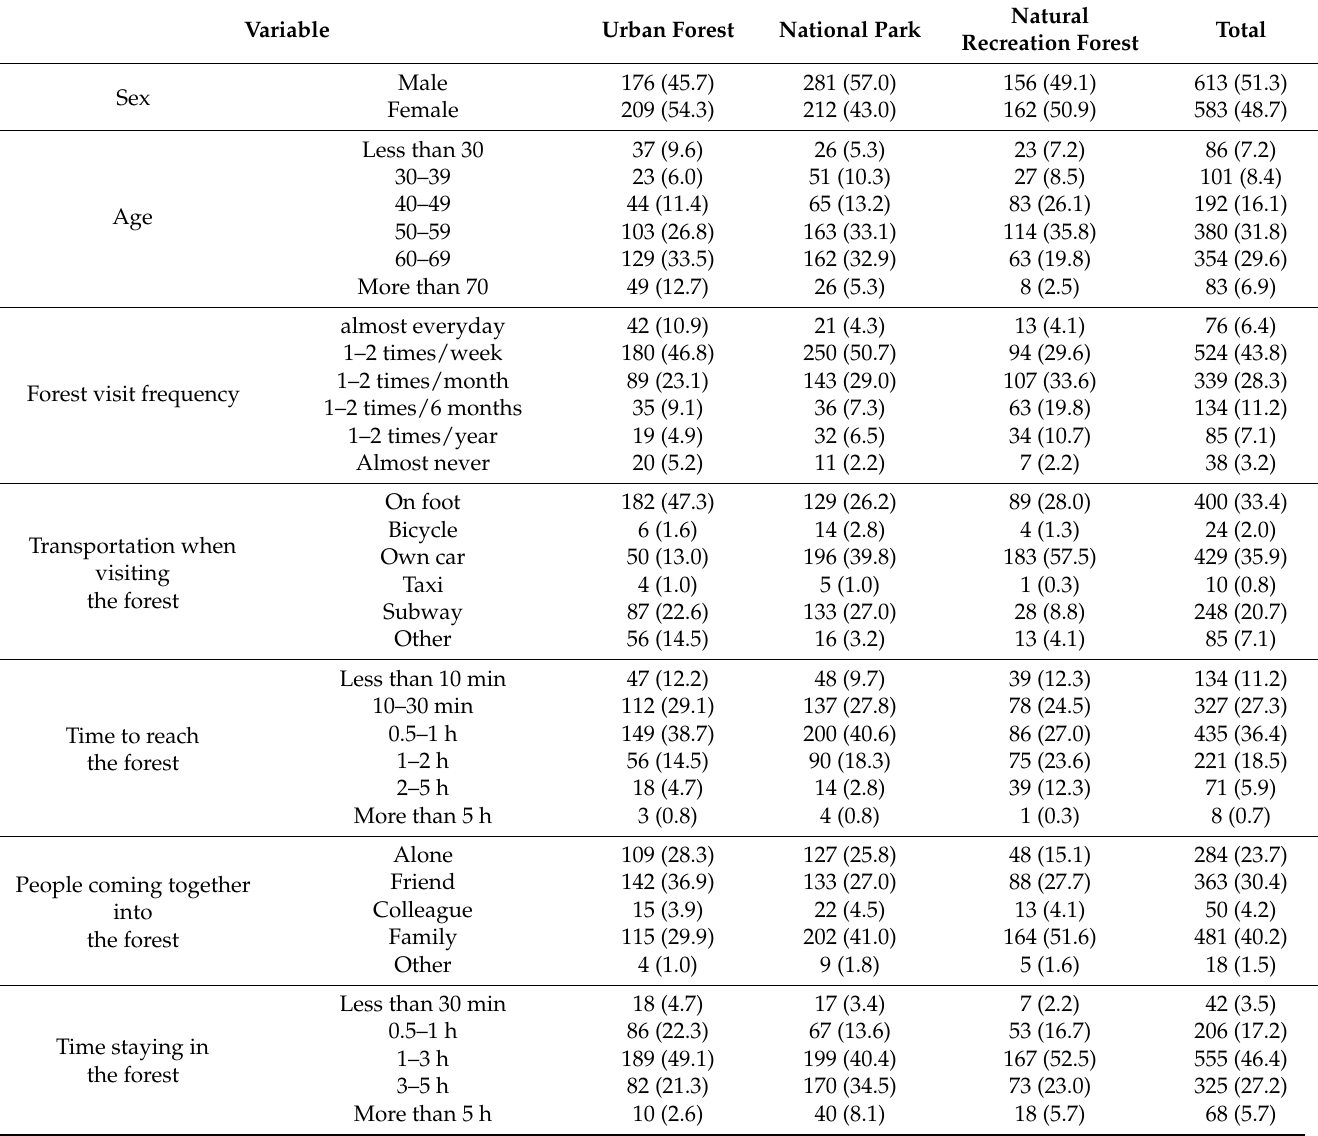
Table 2. Descriptive characteristics of the study